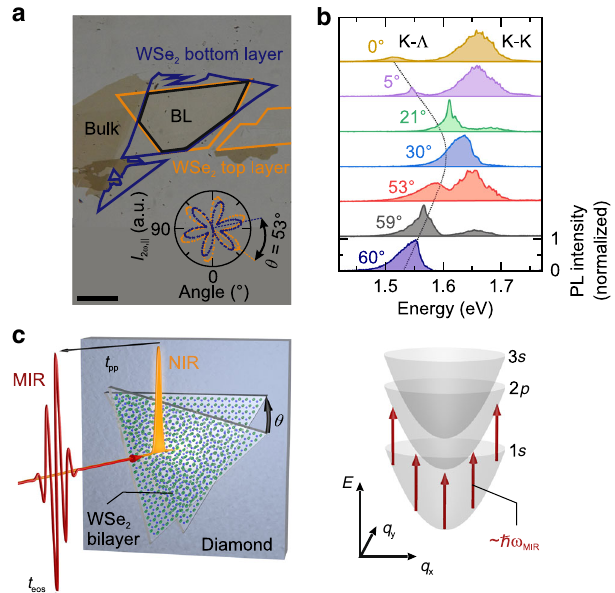
Fig. 1 NIR pump – MIR probe spectroscopy of twisted WSe 2 bilayers. a Optical microscope image of a representative twisted homobilayer